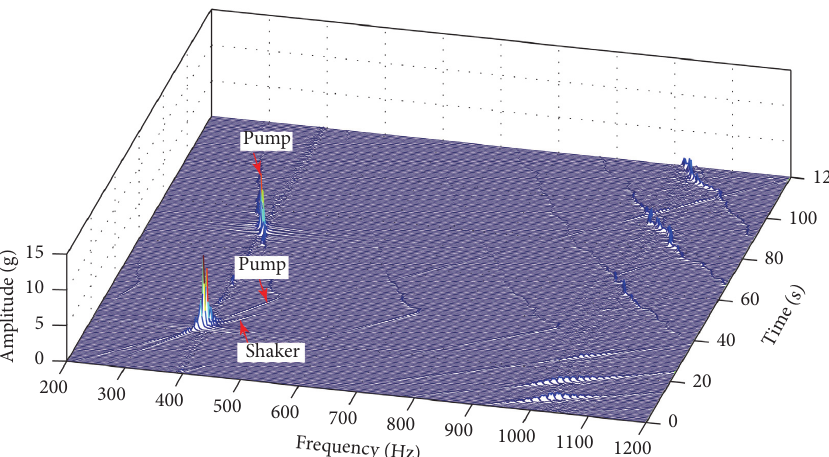
Figure 11: Three-dimensional waterfall of dynamic response under the superposition of variable pressure pulsation frequency and variable base excitation frequency.